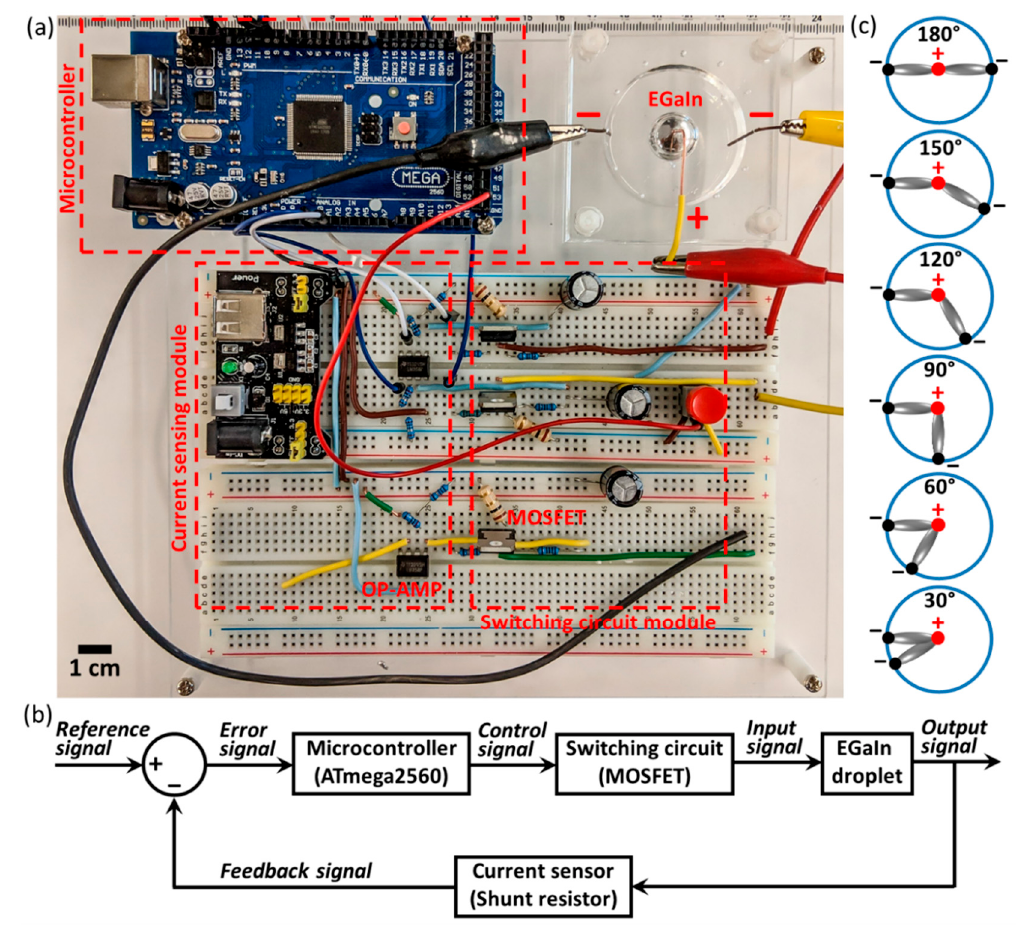
Figure 1. ( a ) A photograph of the experimental setup. ( b ) A scheme of the feedback control system. ( c ) Schematics illustrating the proposed morphological control of the EGaIn droplet using six different configurations of electrodes.